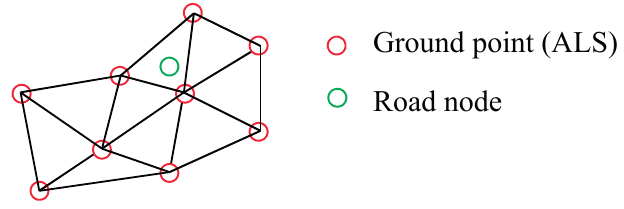
Figure 12. Road node projected onto a ground TIN model.